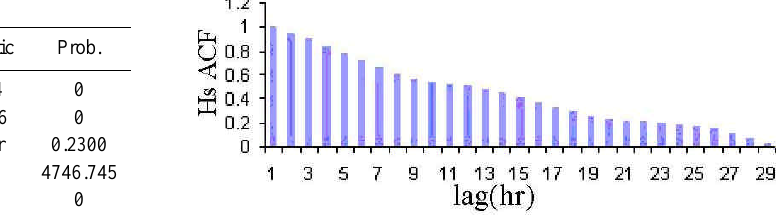
Table 3. Statistical coefficient of significant wave height time series model.